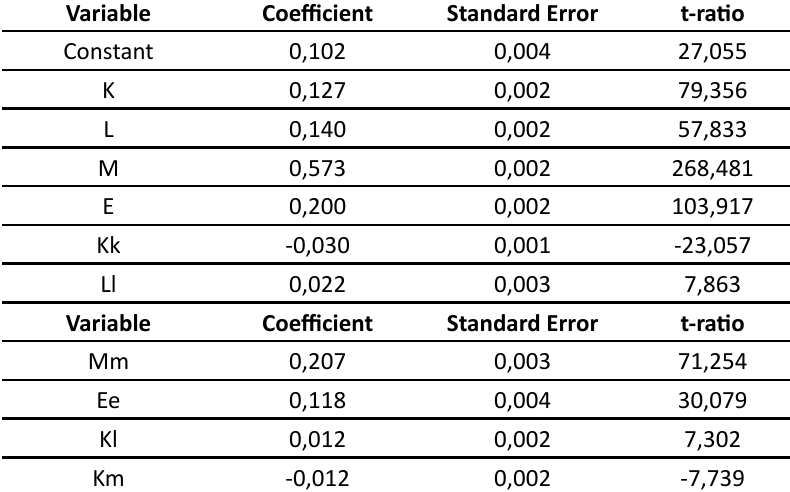
Table 3: Results of Estimation Models of Inefficiency Effects on the Translog Production